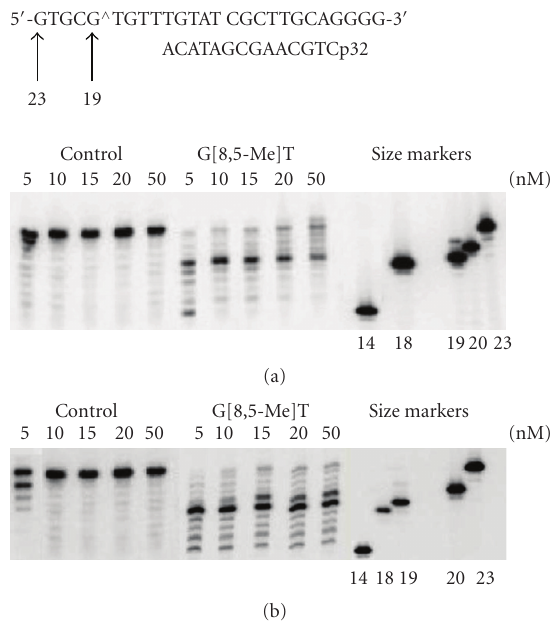
Figure 2: Extension of a 14-mer primer by varying concentration (5, 10, 15, 20, and 50nM) of hPol η (a) and yPol η (b) on control and G[8,5-Me]T templates in the presence of all four dNTPs. The experiments were carried out at 37 ◦ C for 30